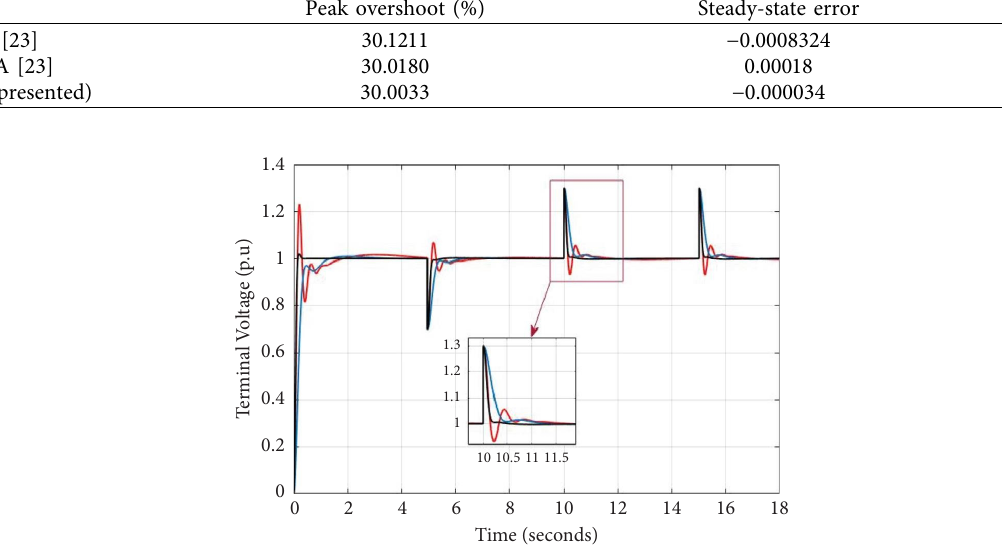
Figure 5: Response of terminal voltage under variation of ± 30% load